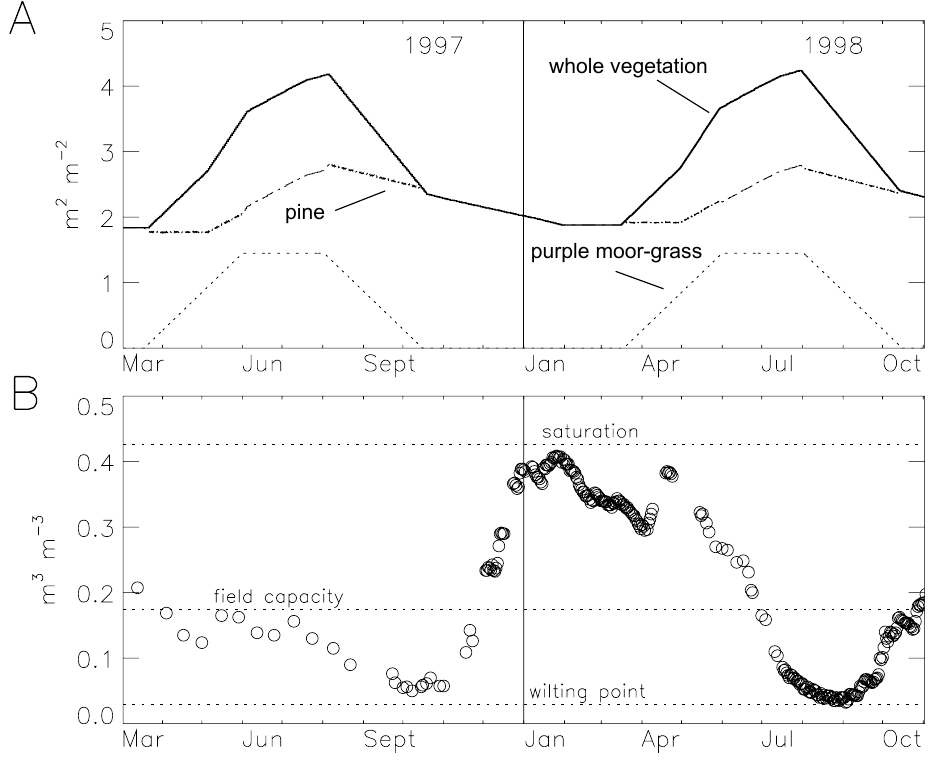
Fig. 1. Observed (A) leaf area index (LAI) and (B) root-zone soil moisture for Le-Bray. The Le-Bray LAI is the sum of the pine and purple moor-grass LAI (long- and short- dashed lines, respectively). Soil moisture measurements concern the 0.8m soil